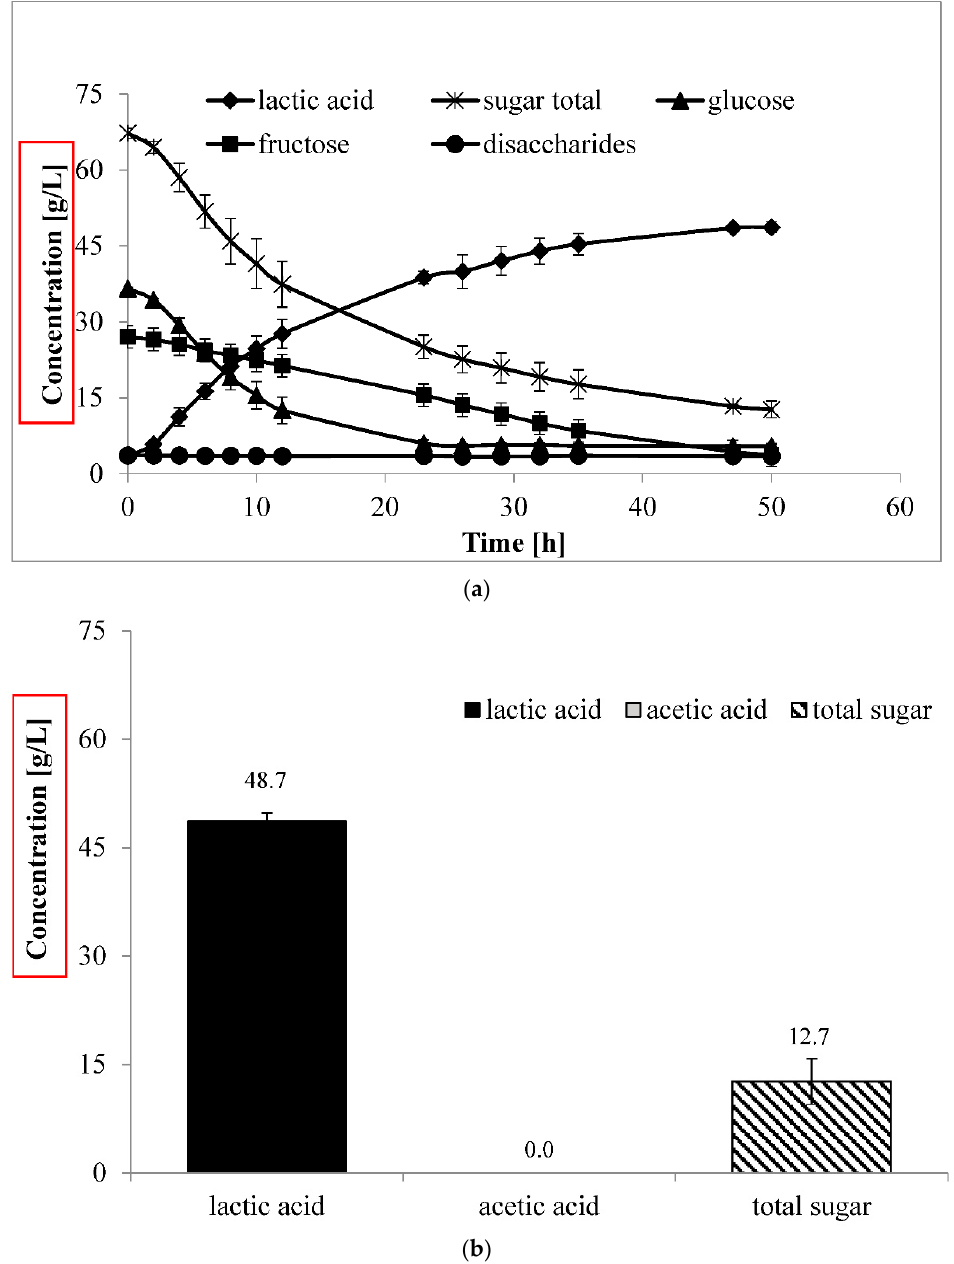
Figure 3. ( a ) B. coagulans fermentation carried out on a pilot scale (35 L) using SHCF as the sole carbon and nutrient source. Fermentative production of LA and consumption of glucose, fructose, and disaccharides, with time, during 50 h of fermentation, using 2 pilot scale fermenters. Each data point is the mean ± SD. ( b ) The B. coagulans fermentation process was carried out on a pilot scale (35 L) using SHCF as the sole carbon and nutrient source. Fermentative production of LA and lactic acid, acetic acid, and total sugars at the end, after 50 h of fermentation using 2 pilot scale fermenters. Each bar is the mean ± SD.